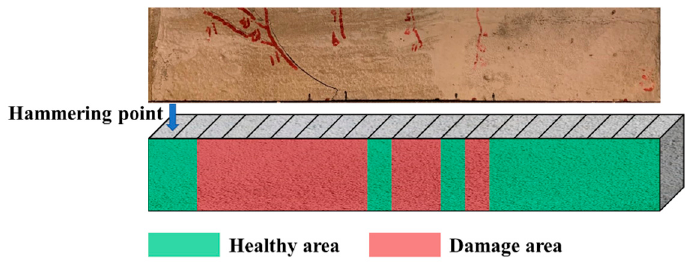
Figure 8. Schematic diagram of the concrete damage area for the two-category classification.